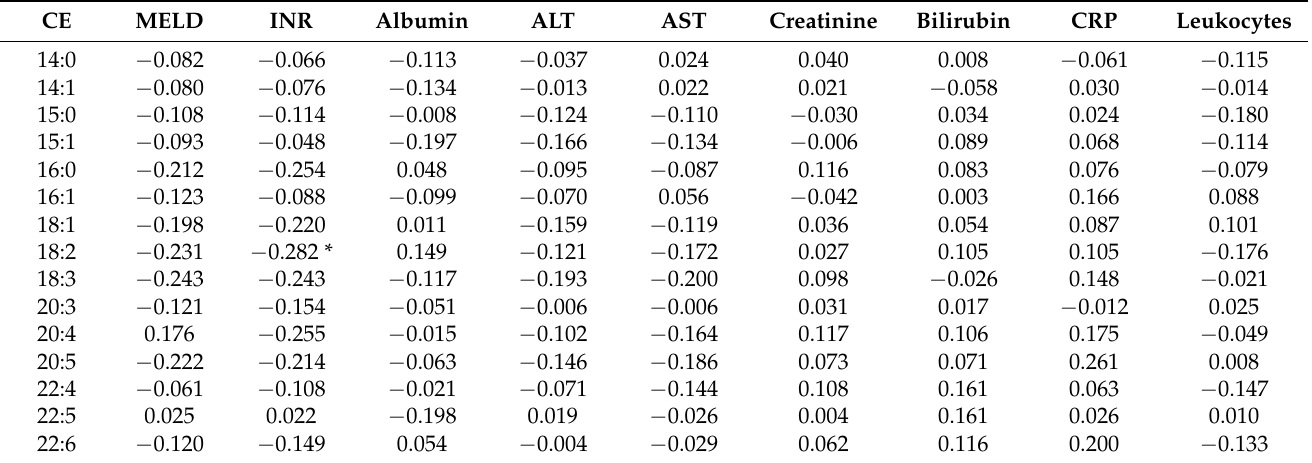
Table 1. Spearman correlation coefficients of CE species and the MELD score as well as laboratory measures of patients without diabetes and without liver cirrhosis before therapy. * p < 0.05.